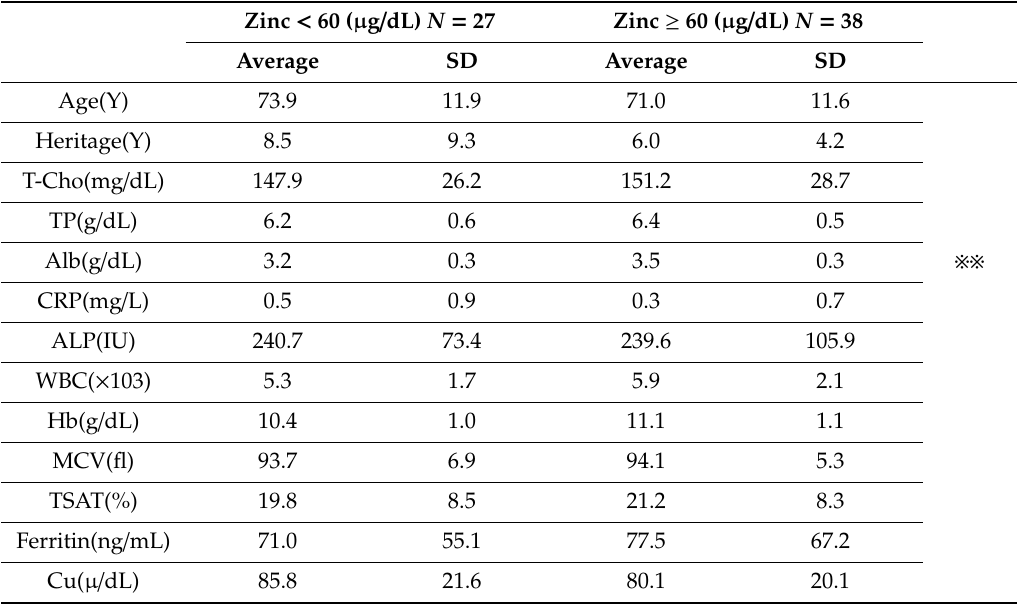
Table 1. Explainable variable for two subgroups, binominal logistic reggresion analysis ( N = 65).